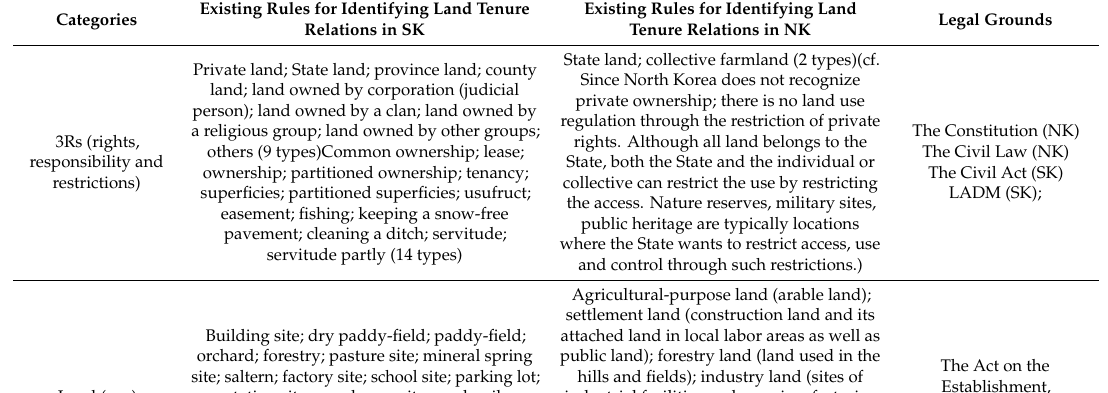
Table 3. Existing rules for defining land tenure relations in the context of Korean (re-)unification (functional